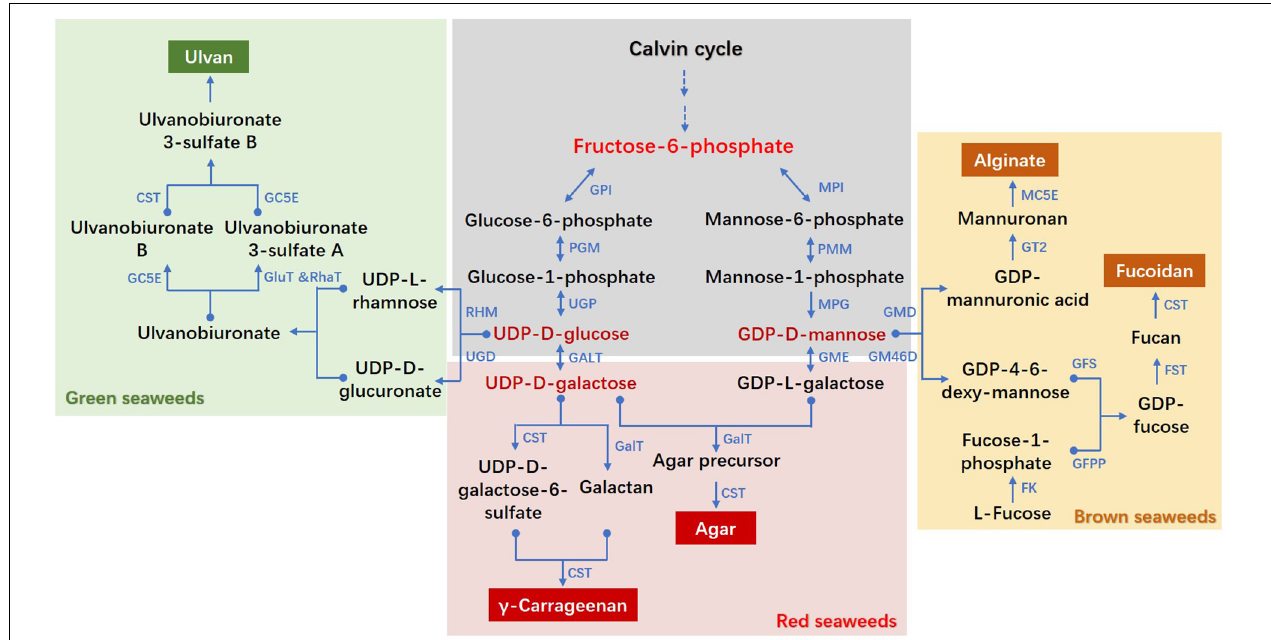
FIGURE 1 | Proposed biosynthesis pathways of cell wall polysaccharides in seaweeds. CST, carbohydrate sulfotransferase; FK, fucokinase; FST, fucosyltransferase; GalT, galactosyltransferase; GALT, galactose-1-phosphate uridylyltransferase; GC5E, glucuronyl C5-epimerase; GFS, GDP-fucose synthetase; GFPP, GDP-fucose pyrophosphorylase; GluT, glucuronyltransferase; GM46D, GDP-mannose 4,6-dehydrogenase; GMD, GDP-mannose dehydrogenase; GME, GDP-mannose-3 (cid:48) ,5 (cid:48) -epimerase; GPI, glucose-6-phosphate isomerase; GT, glycosyltransferase; MC5E, mannuronate C5-epimerase; MPI, mannose-6-phosphate isomerase; MPG, mannose-1-phosphate guanylyltransferase; PGM, phosphoglucomutase; PMM, phosphomannomutase; RhaT, α -1,4-rhamnosyltransferase; RHM, rhamnose synthase; UGD, UDP-D-glucose dehydrogenase; UGP, UTP-glucose-1-phosphate uridylyltransferase. The pathways referred to diverse literatures: (Lahaye and Robic, 2007; Collén et al., 2014; Ficko-Blean et al., 2015; Lee et al., 2017; Chi et al., 2018; Ho et al., 2018; Shao et al., 2019; Lipinska et al.,